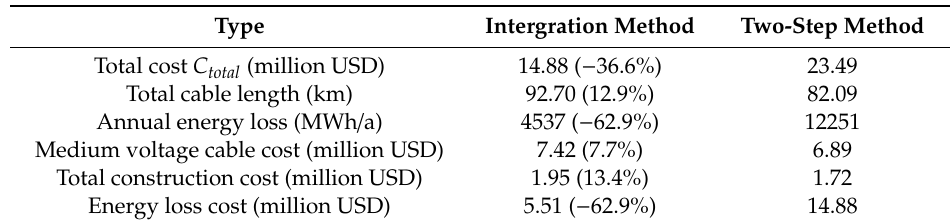
Figure 7. Optimal connection topology generated by ( a ) the integration method and ( b ) the two-step method.